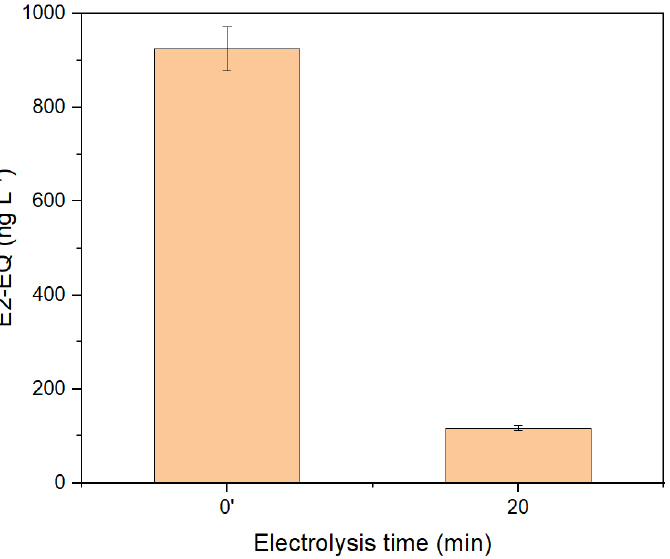
Figure 3. Results of estrogenic activity (E2-EQ) of LNG-GES solutions before and after 20 min of anodic oxidation mediated by chlorine active species ([NaCl] 0 = 0.07 mol L −1 , j = 32.5 mA cm −2 , [LNG] 0 = [GES] 0 = 1.0 mg L −1 ). Measurements performed in duplicate.